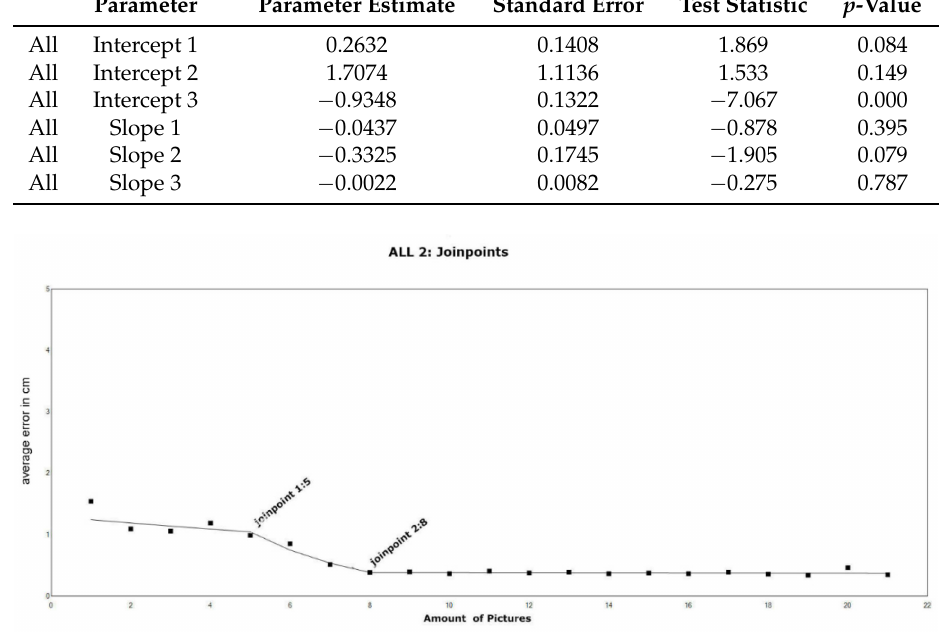
Figure 8. The trend analysis of the data. The error on y-axis, the amount of cameras that see the focal point on